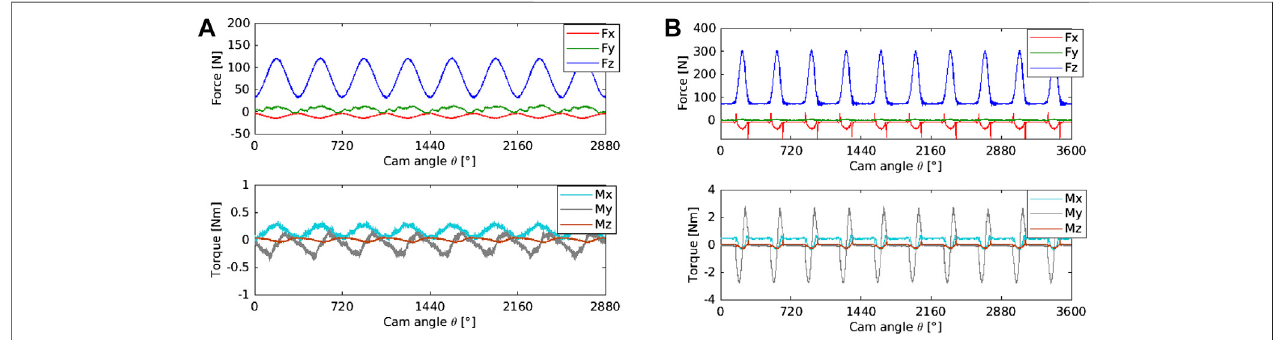
FIGURE 9 | Force and moment components in a tests at 60 rpm. (A) Circular eccentric cam. (B) Spline cam.